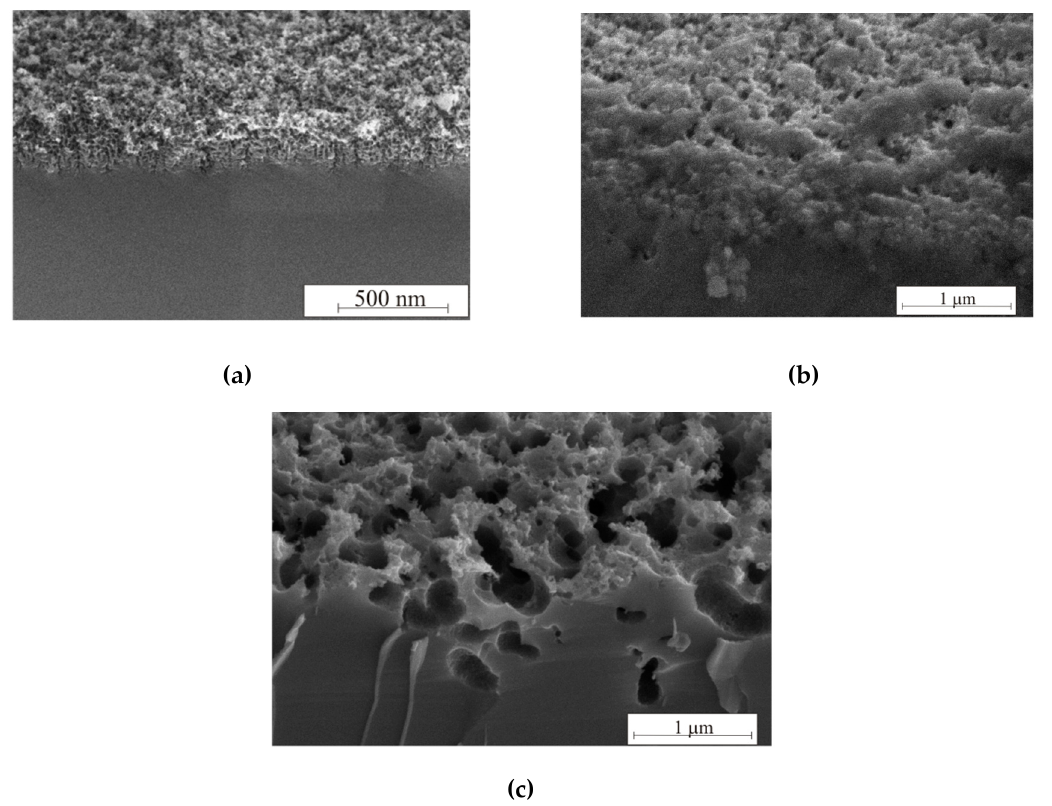
Figure 8. Cross-section of samples formed in the ( a ) dark, and ( b ) 460 and ( c ) 8000 lx .